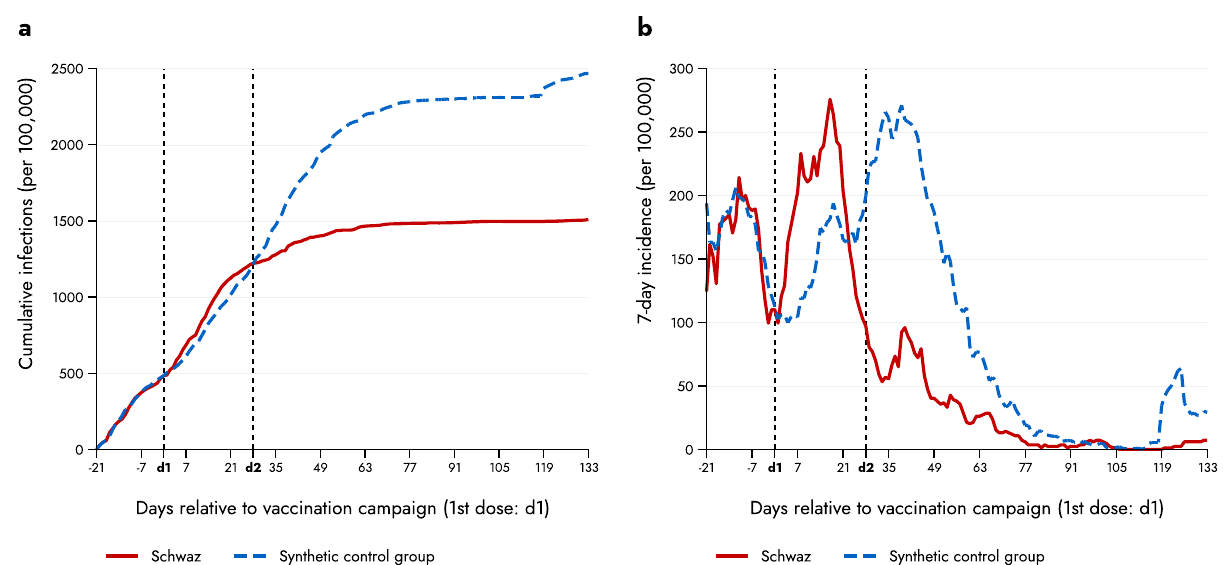
Fig. 2 Daily infections of Schwaz versus synthetic control group. ( a ) depicts cumulative daily infections (per 100,000) for Schwaz (solid red line) and the synthetic control group (dashed blue line). ( b ) shows the 7-day incidence (per 100,000) for Schwaz (solid red line) and the synthetic control group (dashed blue line). The chosen donors include Hartberg-Fürstenfeld (24.1%), Hermagor (10.6%), Liezen (0.5%), Reutte (63.8%) and Steyr Stadt (1.1%). The horizontal axis indicates the number of days relative to vaccination campaign (dose 1, indicated by “ d1 ” ). The pre-treatment period started 21 days (three weeks) before the fi rst dose, the post-treatment period ended 133 days (19 weeks) after the fi rst dose. The vertical dashed lines represent the fi rst dose (d1) and the second dose (d2) administered in the vaccination